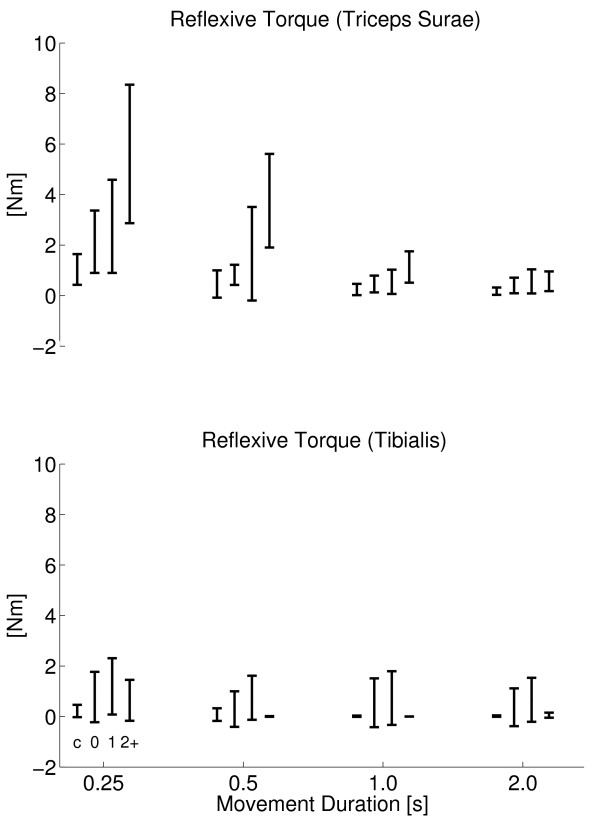
Reflexive torque. Stretch reflex torque (r.m.s.) for all subject groups against movement duration for triceps surae (top) and tibialis anterior (botttom) muscles. Subject groups (C, AS0, AS1, AS2+) from left to right for each cluster, denoted by c, 0, 1 and 2+ respectively.